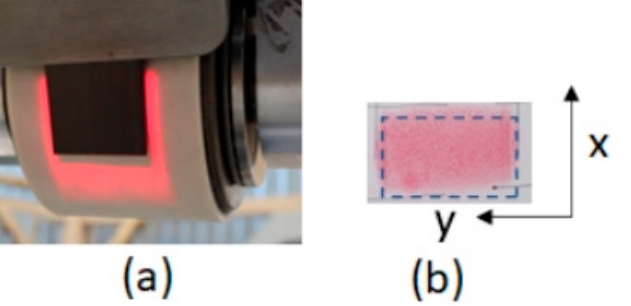
Figure 2. ( a ) Static pressure application with the LATP machine; ( b ) a stained pressure film with the assumed uniform pressure area.